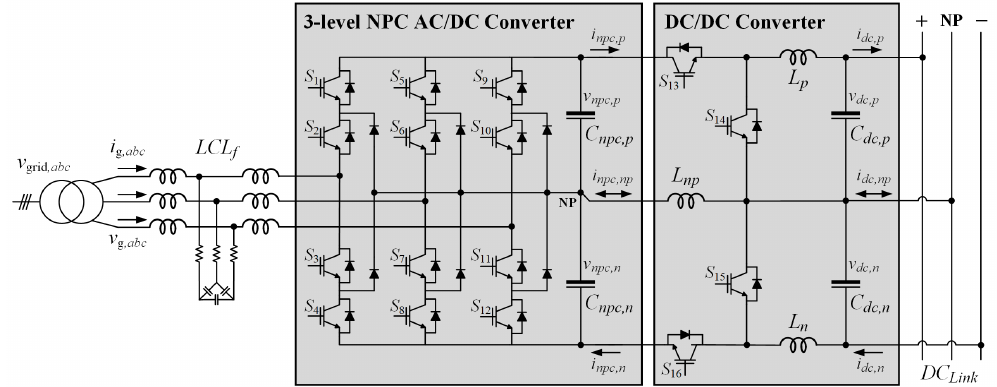
Figure 9. The proposed 3-level NPC AC/DC converter system for LVDC distribution.